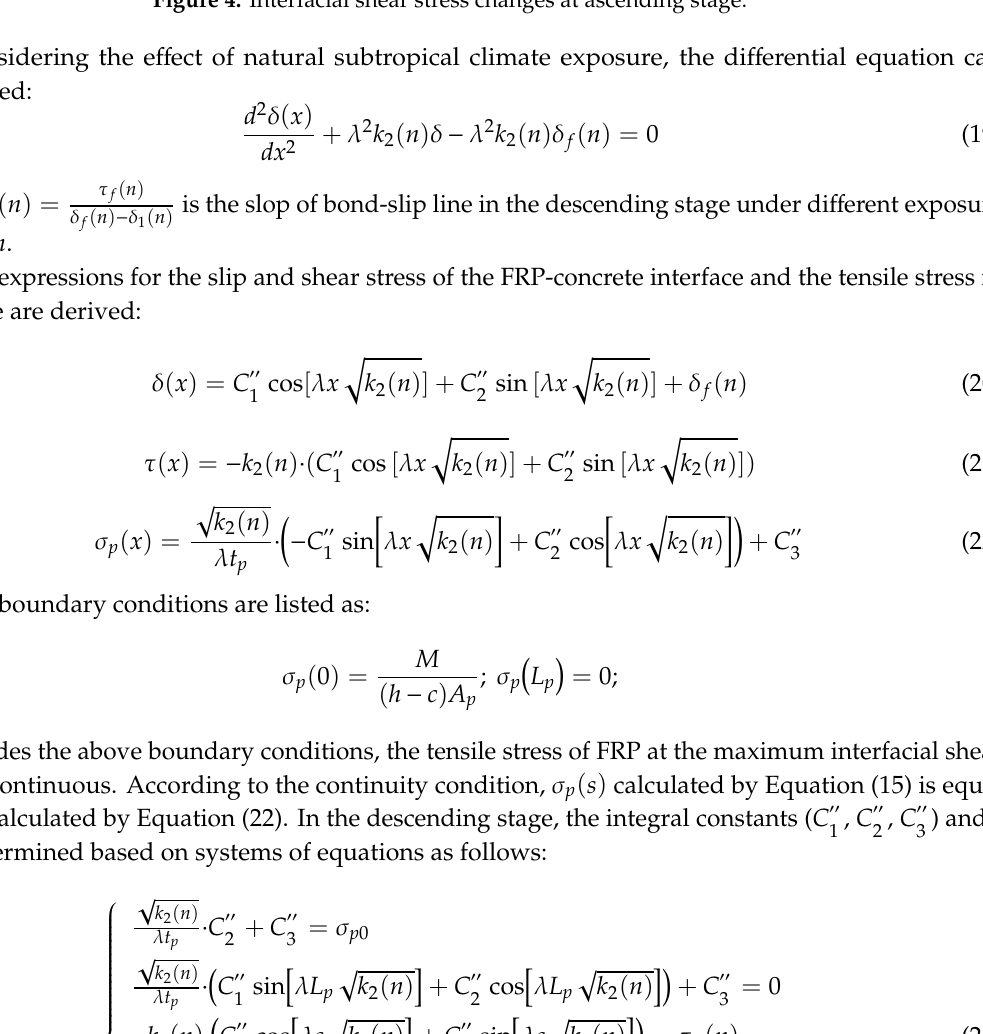
Figure 4. Interfacial shear stress changes at ascending stage.